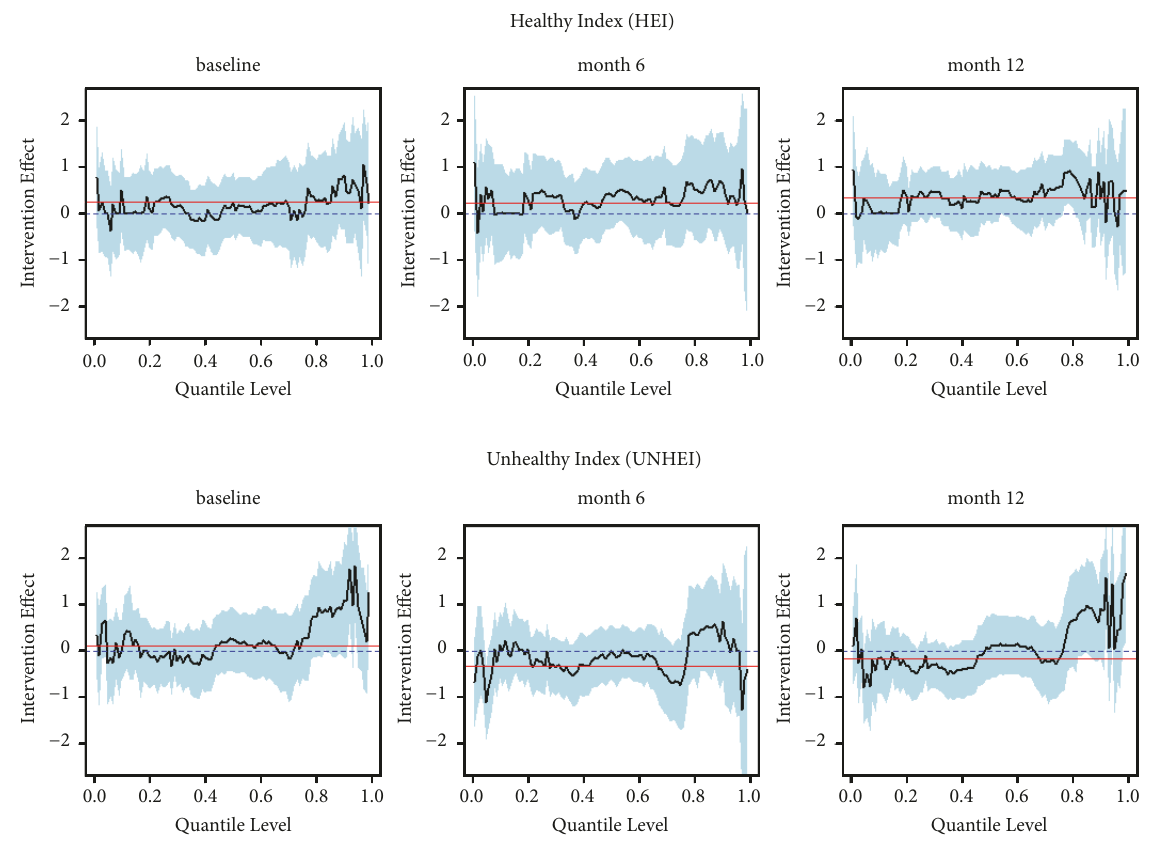
Figure 1: Estimated adjusted ∗ parameter of x 1 for study group (intervention vs. standard care) at each visit based on mean-based regression (red line) and quantile regression (black line with 95% confidence limits) by quantile levels of healthy (HEI) and unhealthy index (UNHEI). ∗ Adjusted for gender, age, diabetes, marital status, years in school, employment status, type of insurance, generation, and preferred